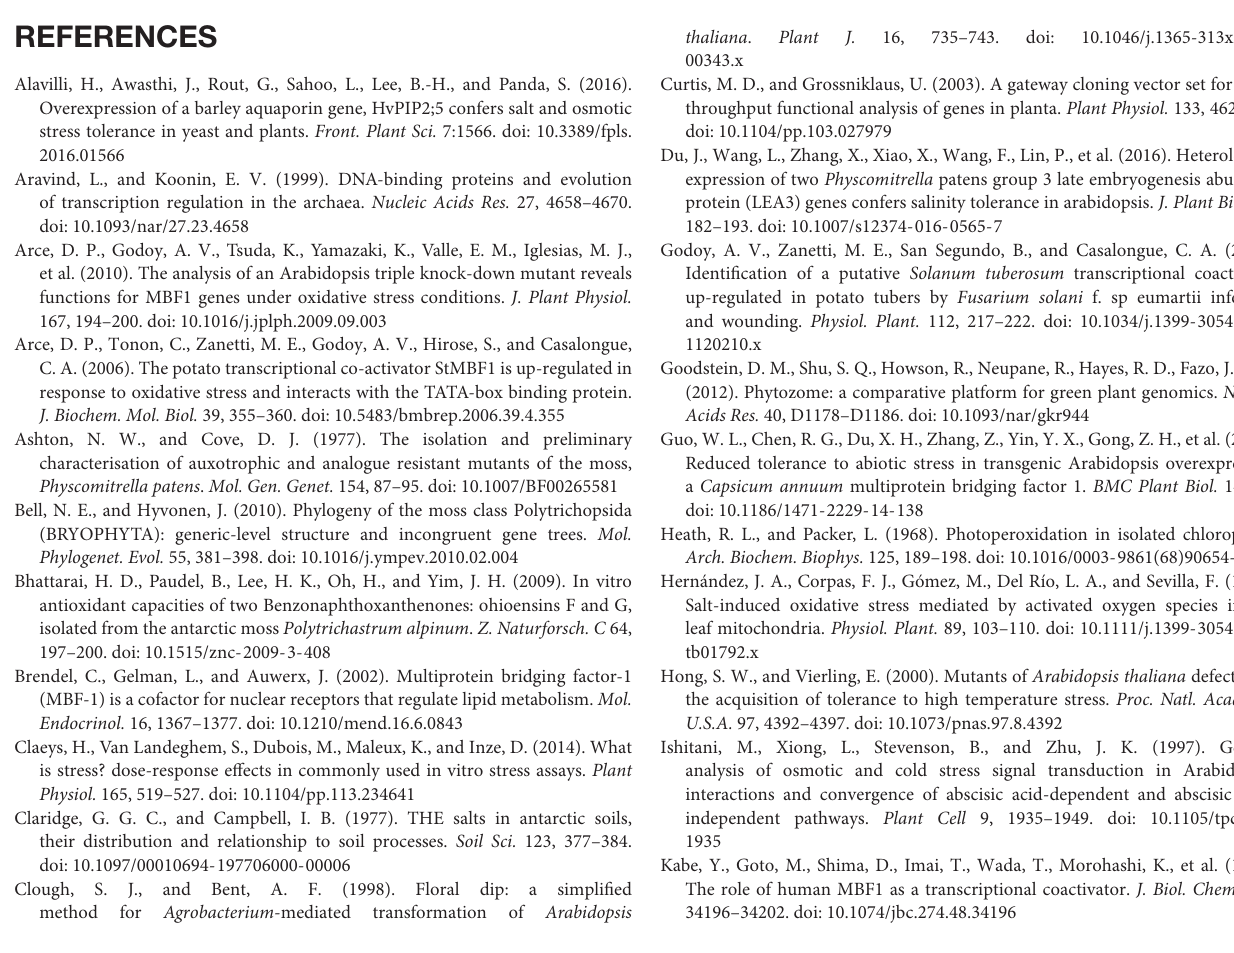
Seedlings on control MS/agar plates for salt and ionic stress treatments. (D) Seedlings on 200 mM NaCl plates (salt stress). (E) Seedlings on 20 mM LiCl plates (ionic stress). FIGURE S4 | PaMBF1c -OE lines showed lower ion leakage than WT at low temperatures. Fully expanded fourth or fifth rosette leaves with petiole from 3-week-old seedlings were used for the experiment. Ion leakage was expressed as a percentage of total electrolytes at a given temperature. Error bars represents standard deviation of the mean values of five independent experiments. FIGURE S5 | Anthocyanin accumulation under salt stress. (A) Ten-day-old seedlings grown on control and 150 mM NaCl plates (salt stress) (B) Quantification of anthocyanin accumulation in each line. Error bars represents standard deviation ( n = 25 seedlings per each treatment). Asterisks indicate statistical significance in LSD test ( p < 0.05). FIGURE S6 | Comparison of germination between PaMBF1c -OE and AtMBF1c -OE lines under different concentrations of mannitol. Error bars represents standard deviation of the mean values of three independent experiments. FIGURE S7 | Validation of the gene expression profiles obtained in RNA-sequencing by qRT-PCR. Relative expression levels of selected genes were determined by qRT-PCR using the cDNA synthesized from RNA isolated from the 14-day-old seedlings treated to high salt stress (300 mM NaCl for 6 h). (A) RING/U-box super family protein (At1g33480); (B) lipid transfer protein 4 (At5g59310); (C) Fe-superoxide dismutase (At4g25100); (D) hypothetical protein (At5g26970). Arabidopsis Clathrin (At4g24550) gene was used as an internal control for normalization of different cDNA samples. Three biological replicates were averaged and error bars represent standard deviation.